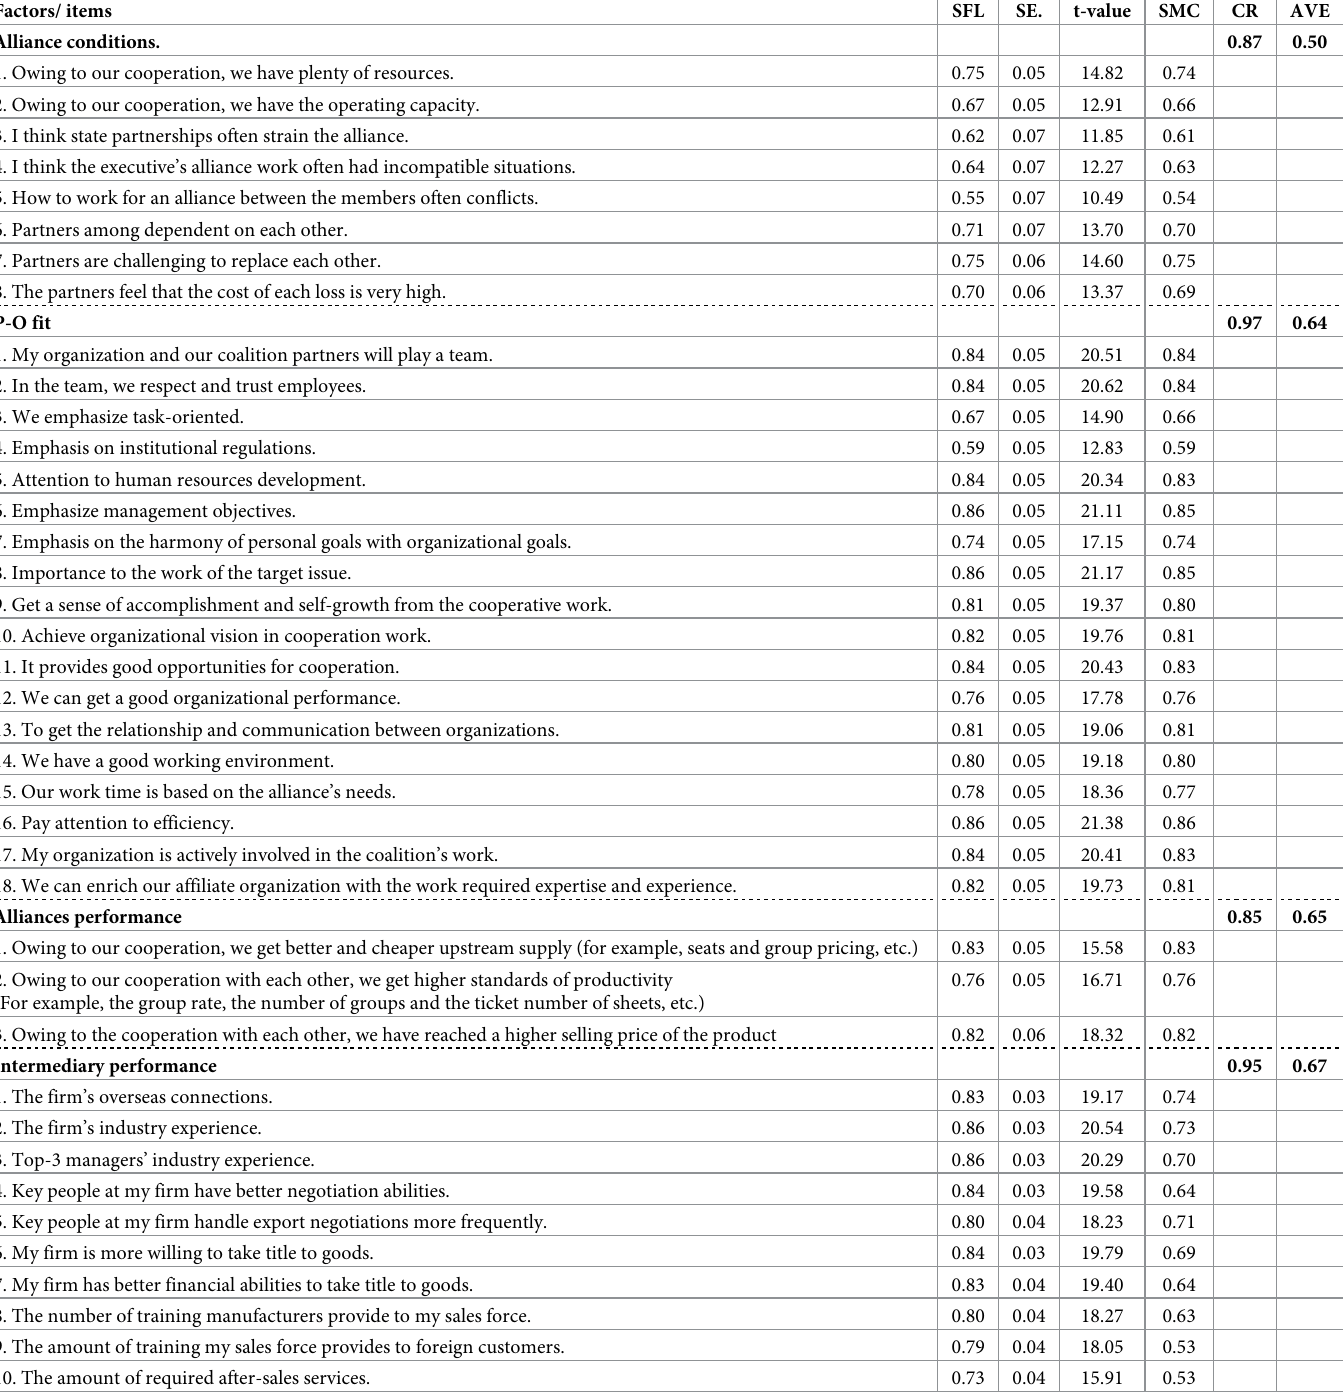
Table 2. CFA results. Factors/ items SFL Alliance